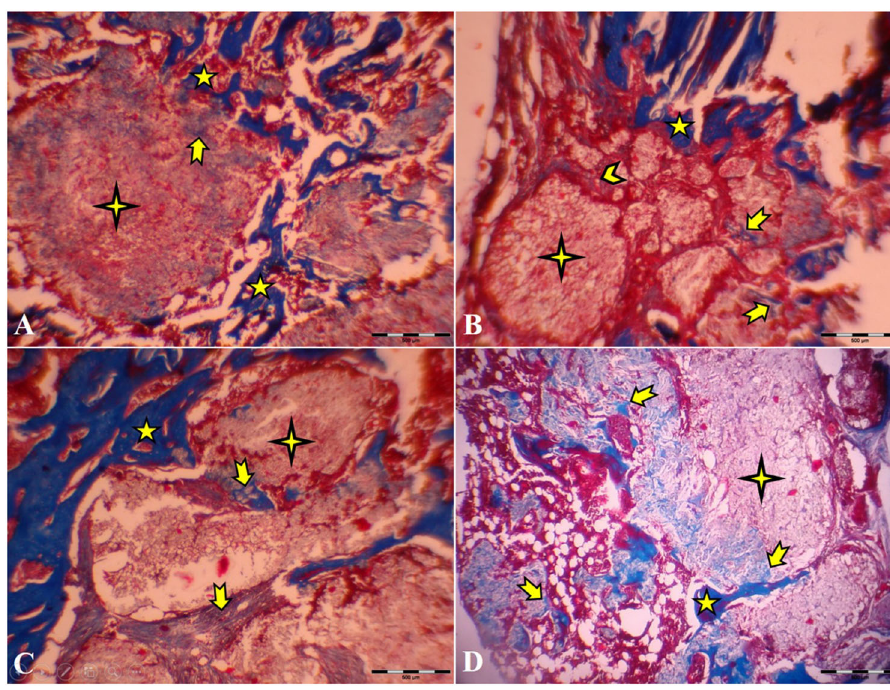
Fig. 6 Microscopic section from the healing site of defect on the 30th day postoperation. A Control group developed scanty new bone around the granulation tissue. B The autograft group shows remains of the necrotic bone and more new bone formation. C HA that presents new bone formation. D : TCP-TiO2 materials in the center of the defect. The most developed new bone formation is shown in the TCP-TiO2 group (Trichrome × 40). star: remain previous bone; notched arrow: new bone formation; chevron: necrotic bone; 4-point